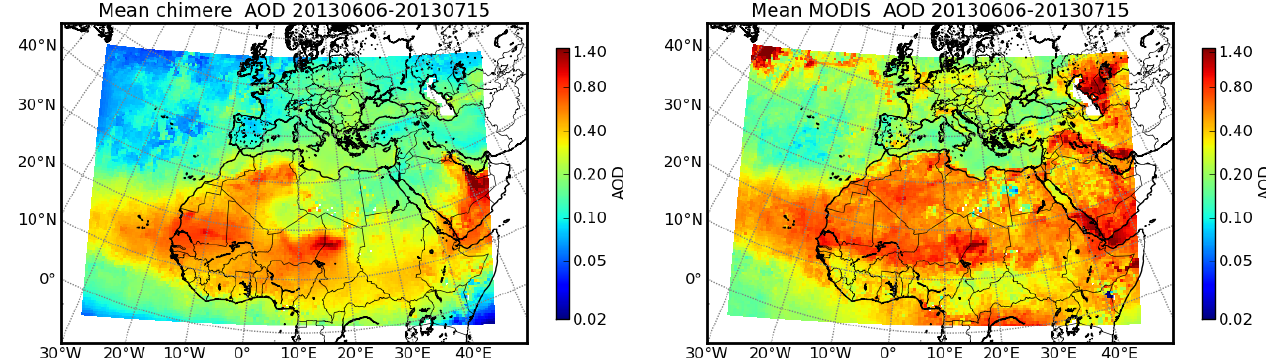
Figure 4. AOD at 550nm in the CHIMERE model (left column) and as observed by MODIS AQUA and TERRA, averaged from 6 June to 15 July 2013. Only the points where MODIS data are available are taken into account in the averaging procedure for the CHIMERE data.